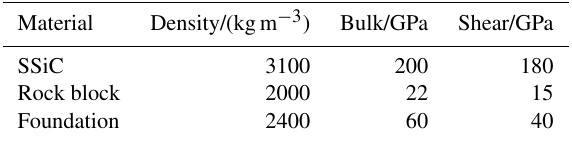
Table 7. Constitutive parameters for matrix.